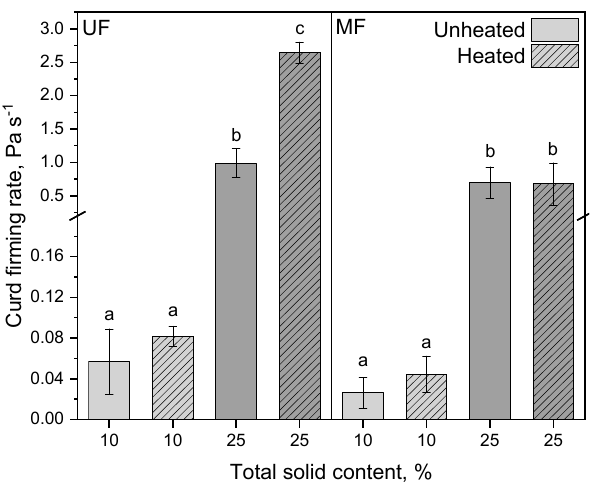
Figure 4. Curd firming rate of unheated and heated reconstituted UF and MF rennet gels with 10 and 25% total solid content. Letters indicate the statistical significance at p ≤ 0.05.